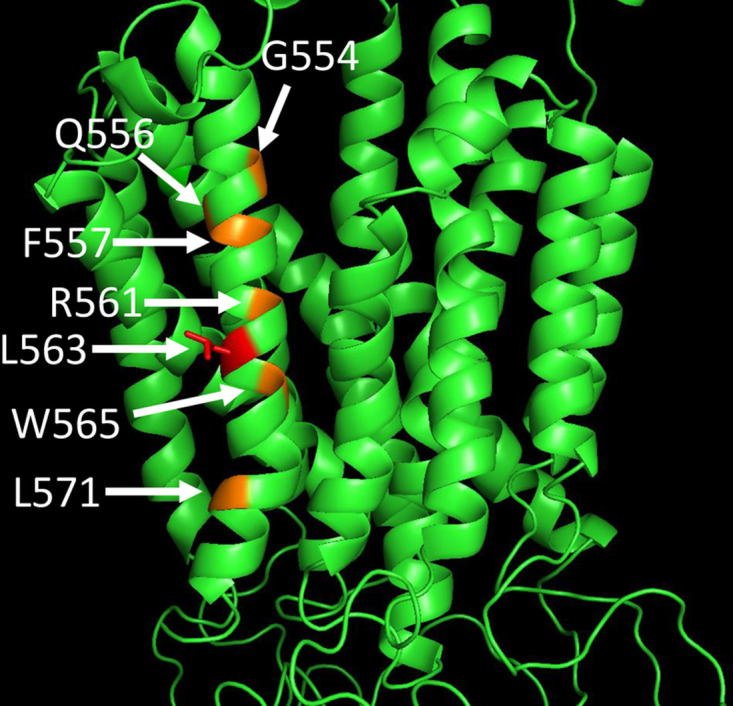
Molecular model of SLCO2A1.A molecular model of SLCO2A1 was constructed using the crystal structure of a glycerol-3-phosphate transporter. The Leu563 in the 11th transmembrane helix is shown in red. The mutations reported in the text are displayed in orange.